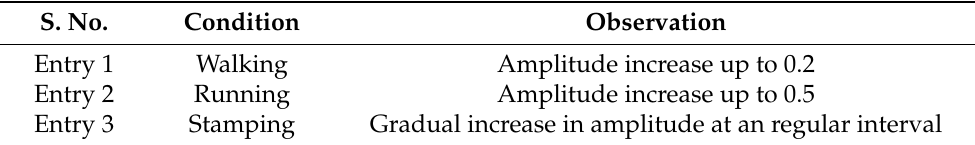
Table 3. Observation of amplitude for signal.